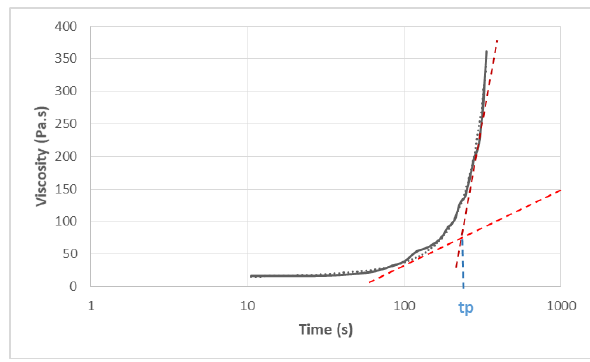
Figure 12: The tangent method for determining the setting